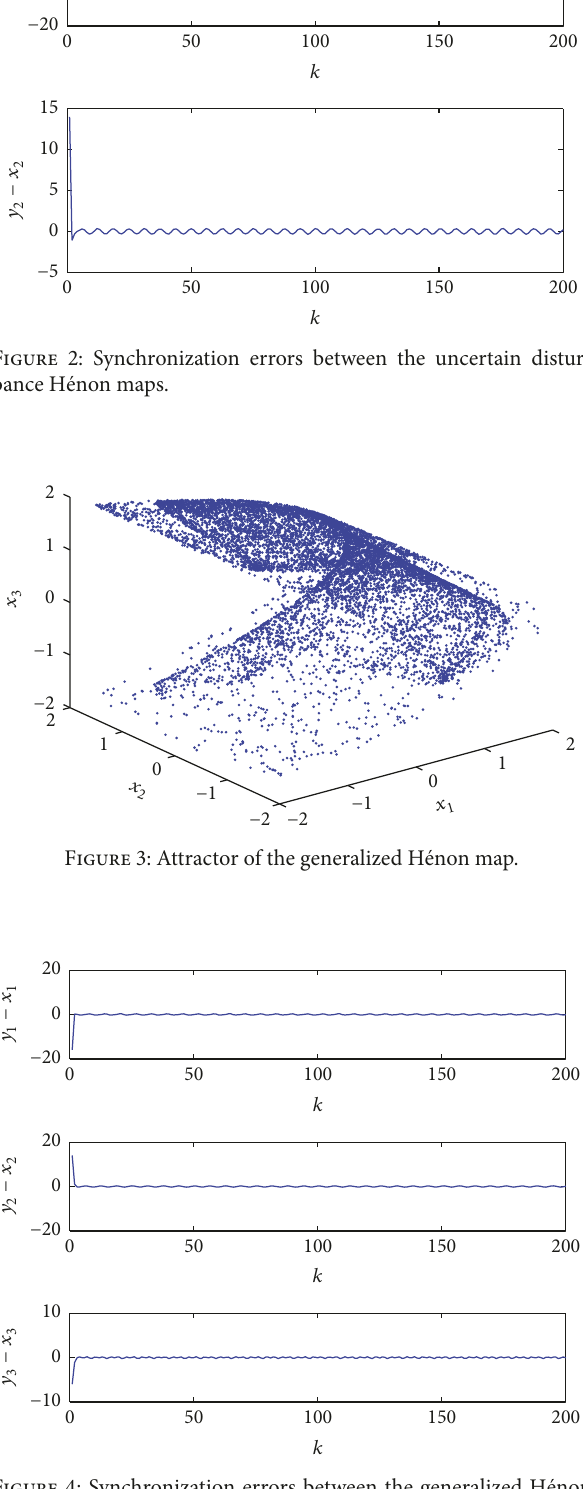
Figure 4: Synchronization errors between the generalized H´enon